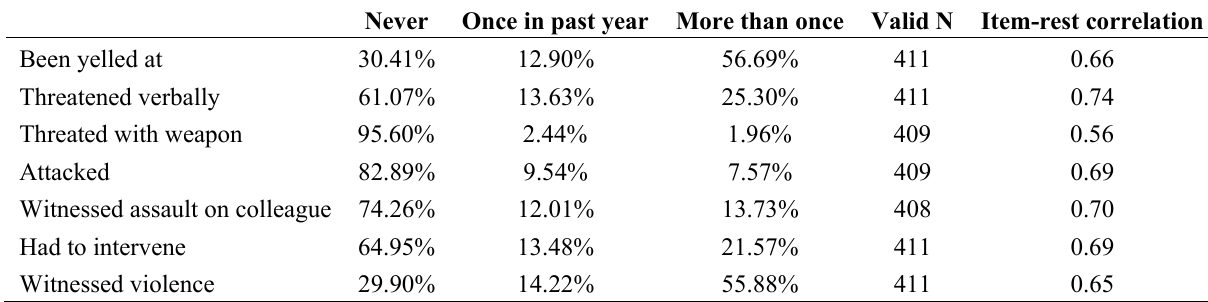
Table 1. Descriptive statistics for violent events while bartending.